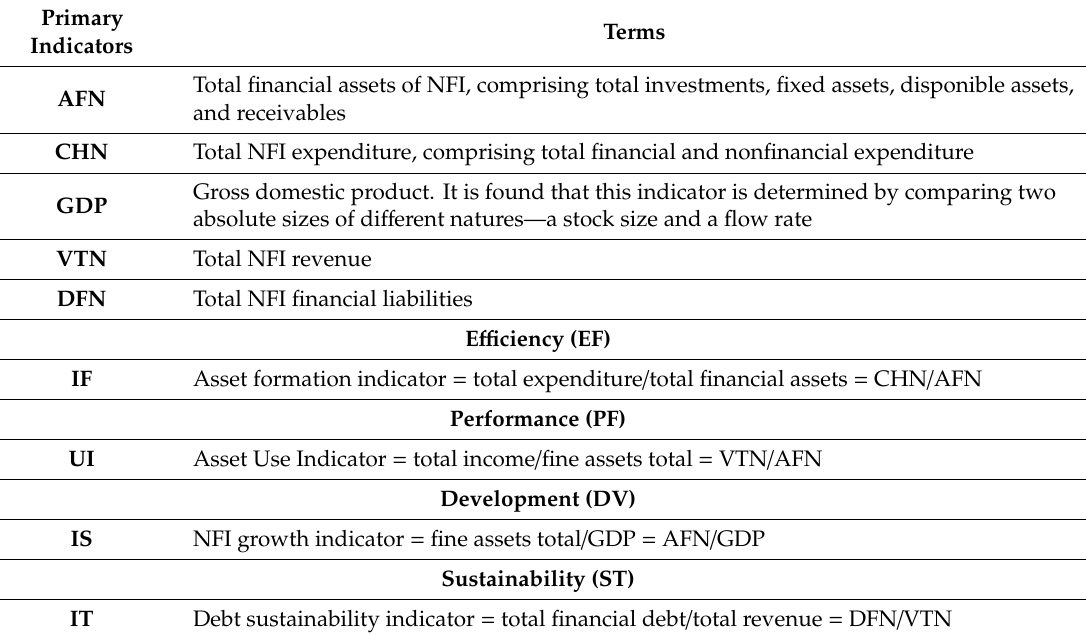
Table 2. Terms of primary and calculated indicators.